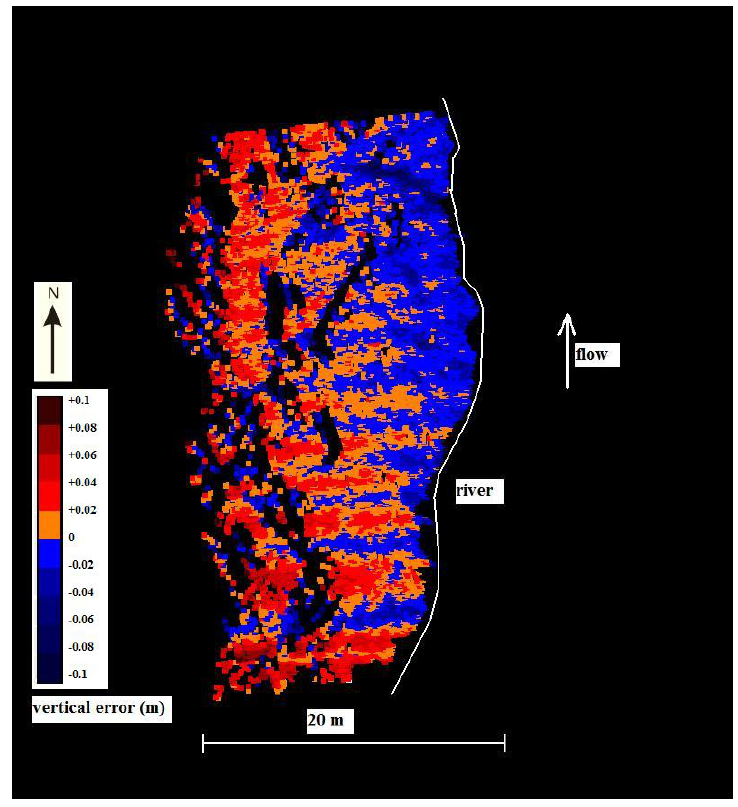
Figure 9. Error surface for BoMMS data for Point Bar